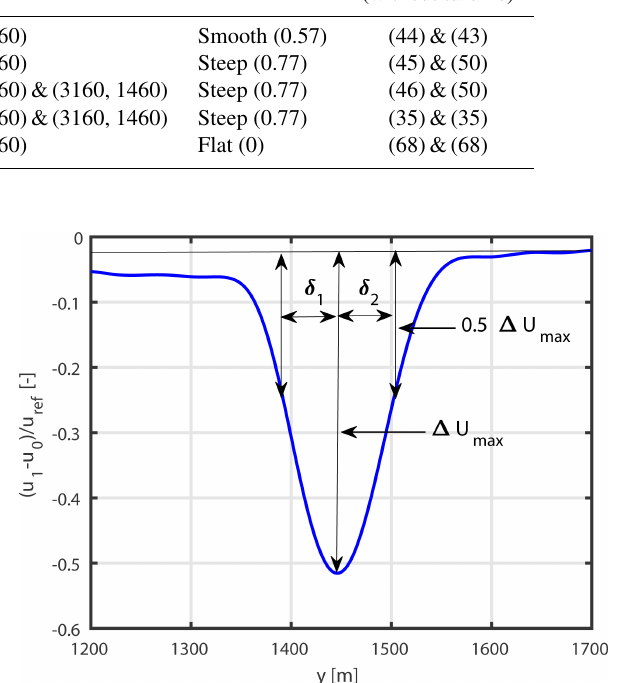
Figure 4. Nomenclature for wake